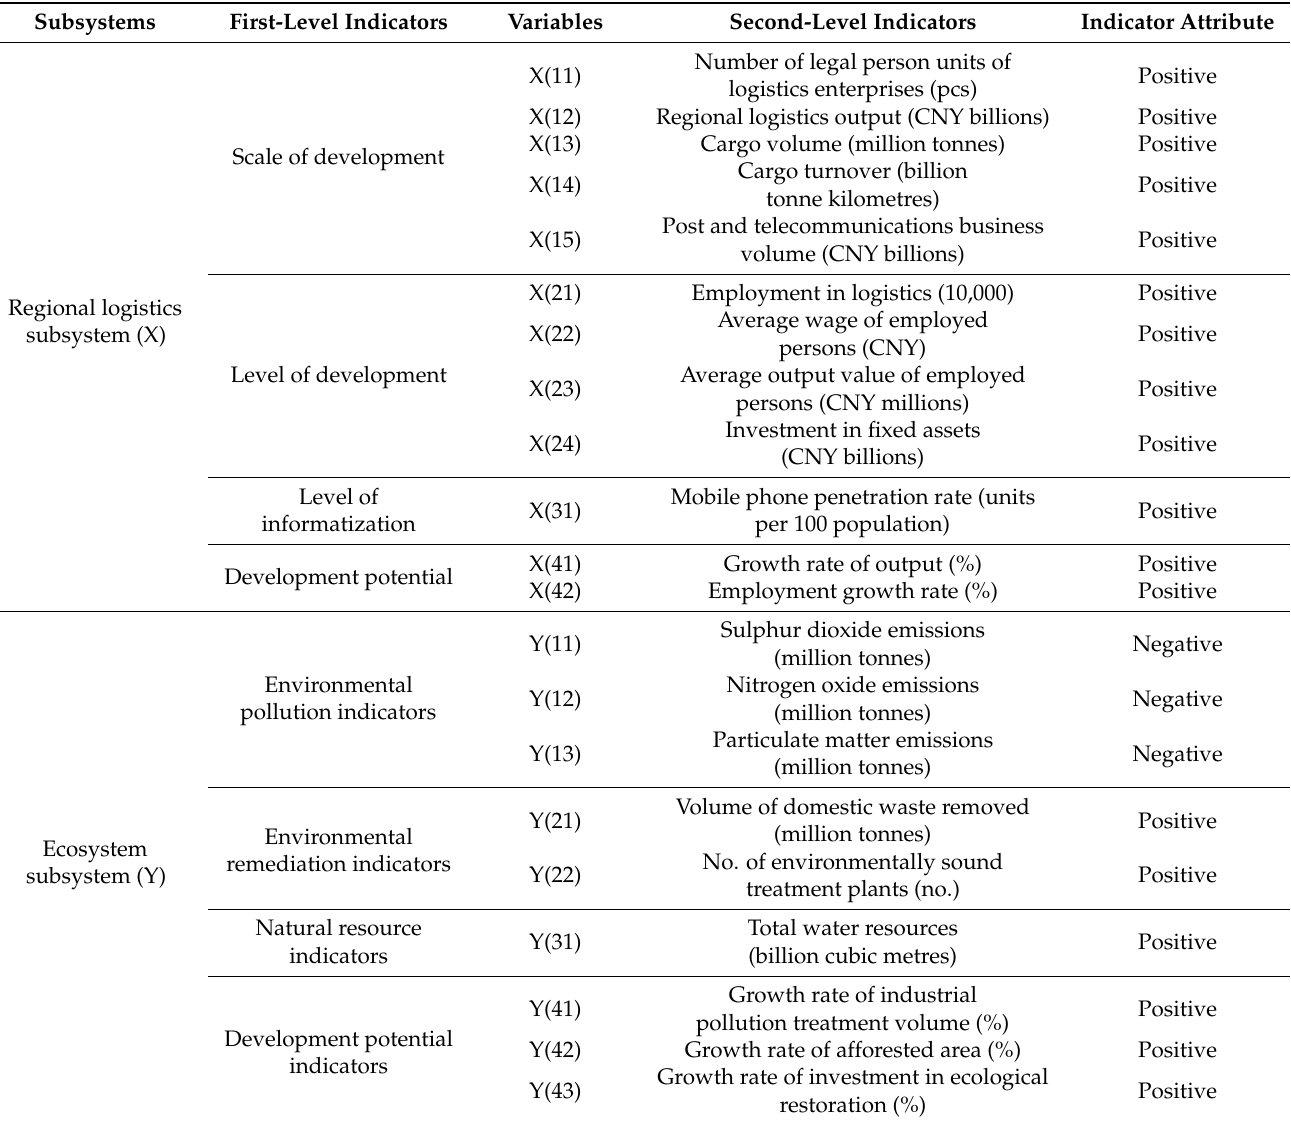
Table 1. Regional Logistics and Ecosystem Indicator